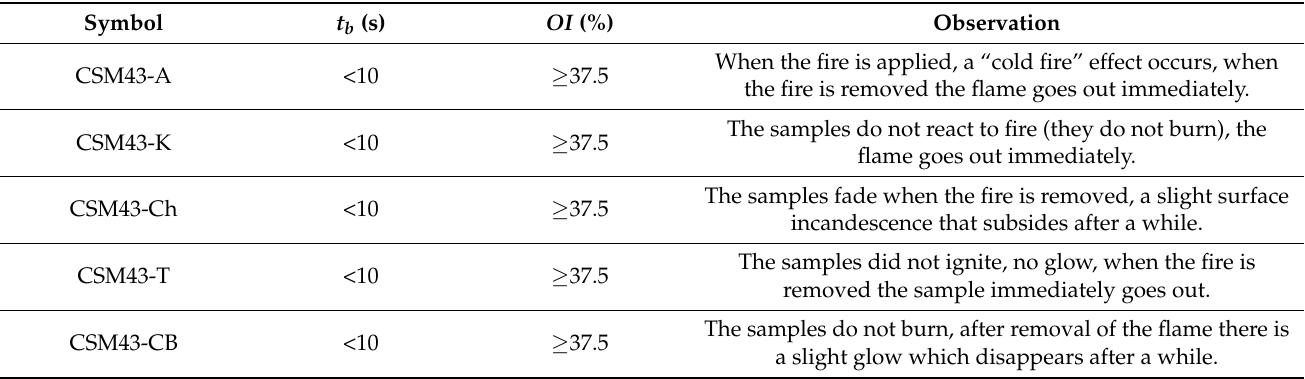
Table 10. Flammability of filled CSM43 vulcanizates; T = 160 ◦ C, t v = 5–15